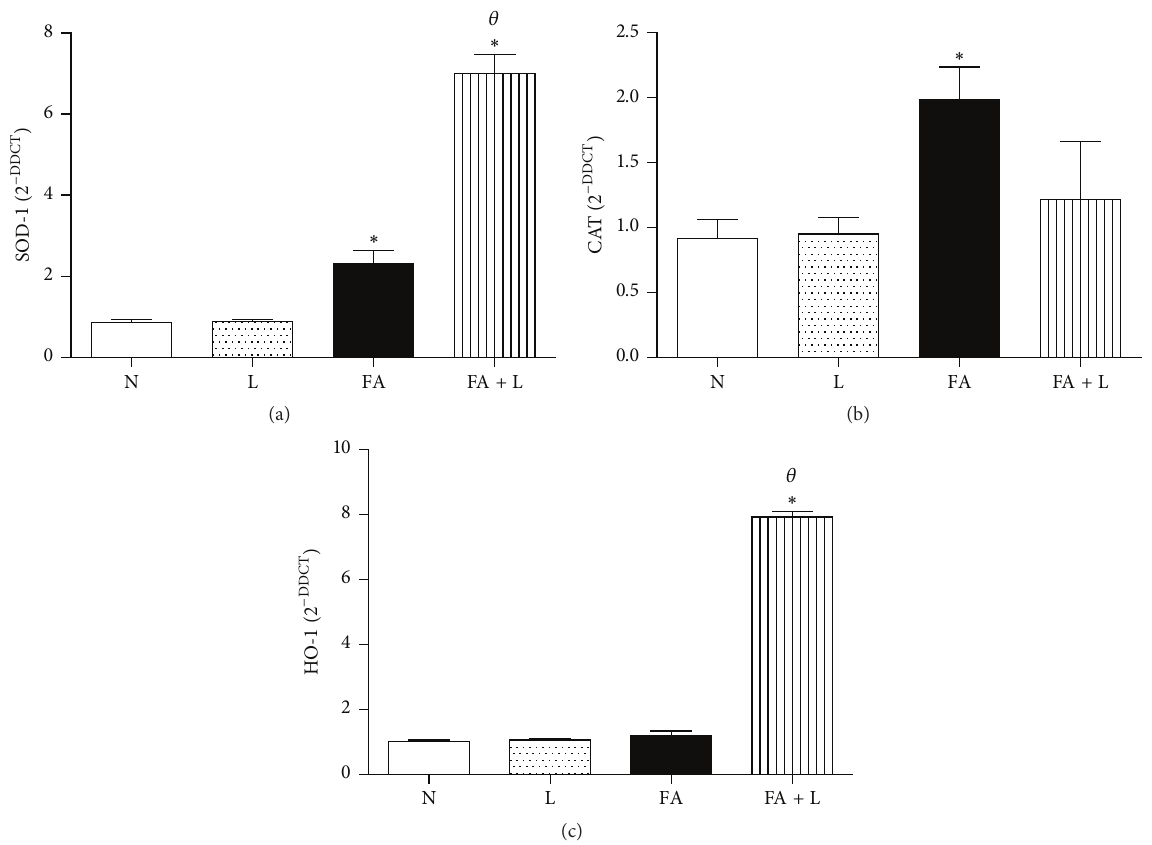
Figure 4: Photobiomodulation therapy increases antioxidant enzymes after FA exposure in the lung. Group of rats was exposed to FA inhalation (1%, 90min/day, 3 days) and treated or not with LLLT (30mW, 1.8J, 60 s/point, total 540s, 1 and 5 h after each FA inhalation). In parallel, group of rats were treated only with laser and nonmanipulated rats were used to obtain basal parameters. The antioxidant enzymes were determined 24 h after the last FA inhalation. Data mean ± SEM of 6 animals per group. ∗ 𝑃 < 0.05 in relation to N and L groups; 𝜃 𝑃 < 0.05 in relation to FA